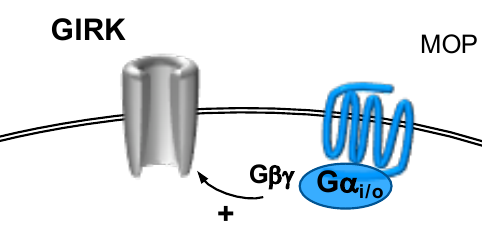
Figure 9. G-protein activated, inwardly rectifying K + channels (GIRK) are activated subsequent to stimulation of G α i / o -coupled receptors. The dissociated G βγ dimer binds directly to GIRK